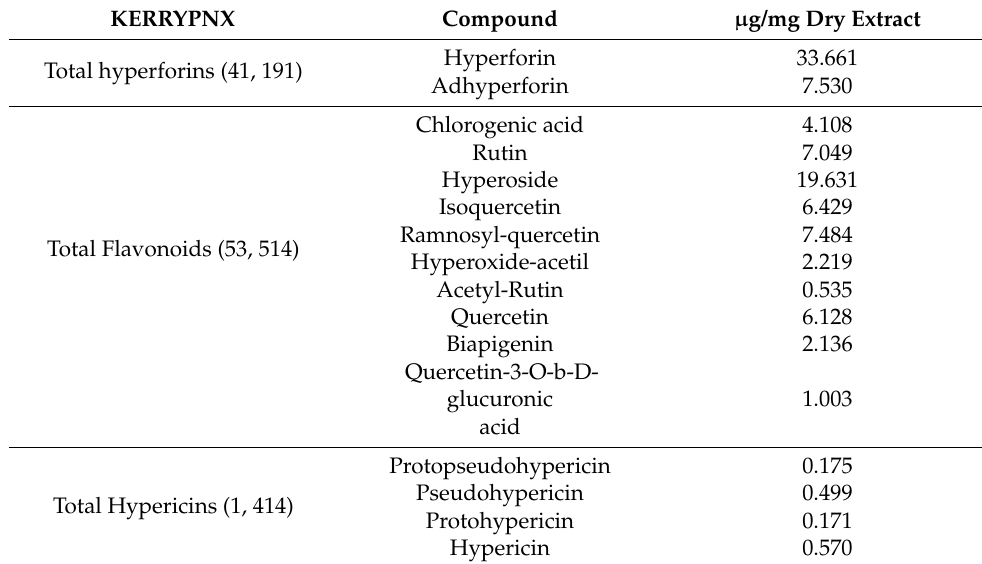
Table 1. Compounds found in the dry extract of the HP plant. KERRYPNX Compound µ g/mg Dry